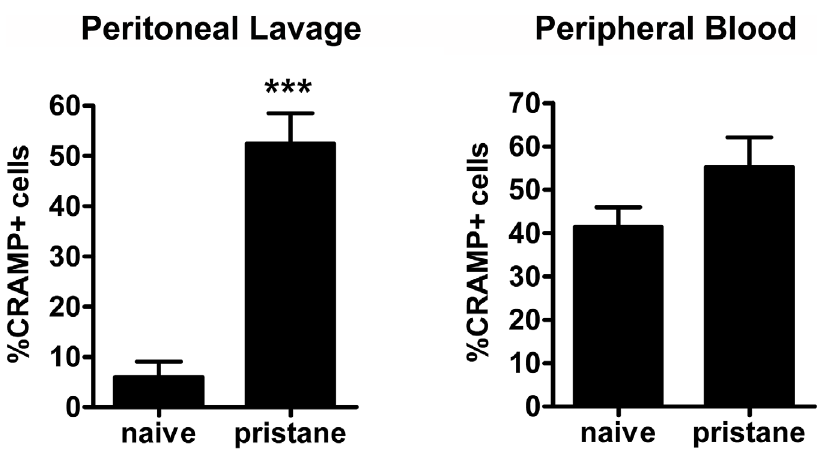
Fig. 3. Percentage of CRAMP-expressing cells is higher in pristane-injected animals. Percentage of CRAMP + cells in peritoneal lavage and peripheral blood of naı ¨ ve mice and mice 7 days after pristane- injection. N 5 5. *P , 0.001, as determined by Student’s